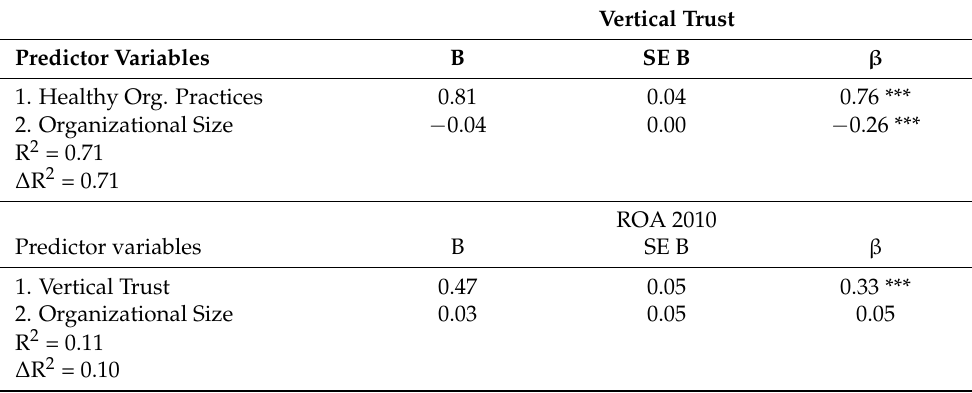
Table 4. Regression analyses by aggregating data (N = 31).